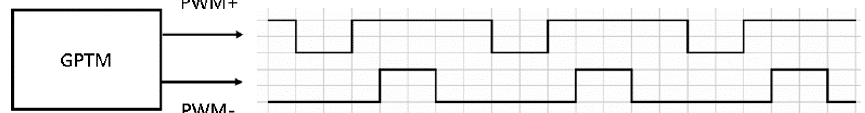
Figure 13. Base PWM signals for generating a sine wave in the conductivity readout circuit.